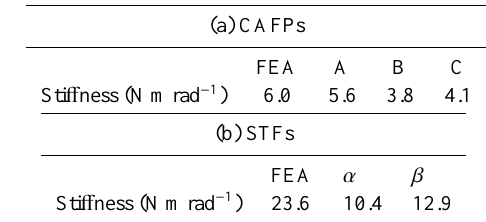
Table 6. Predicted and measured sti ff nesses of two flexure types. A, B, C, α , and β designate average values of sti ff ness for each prototype